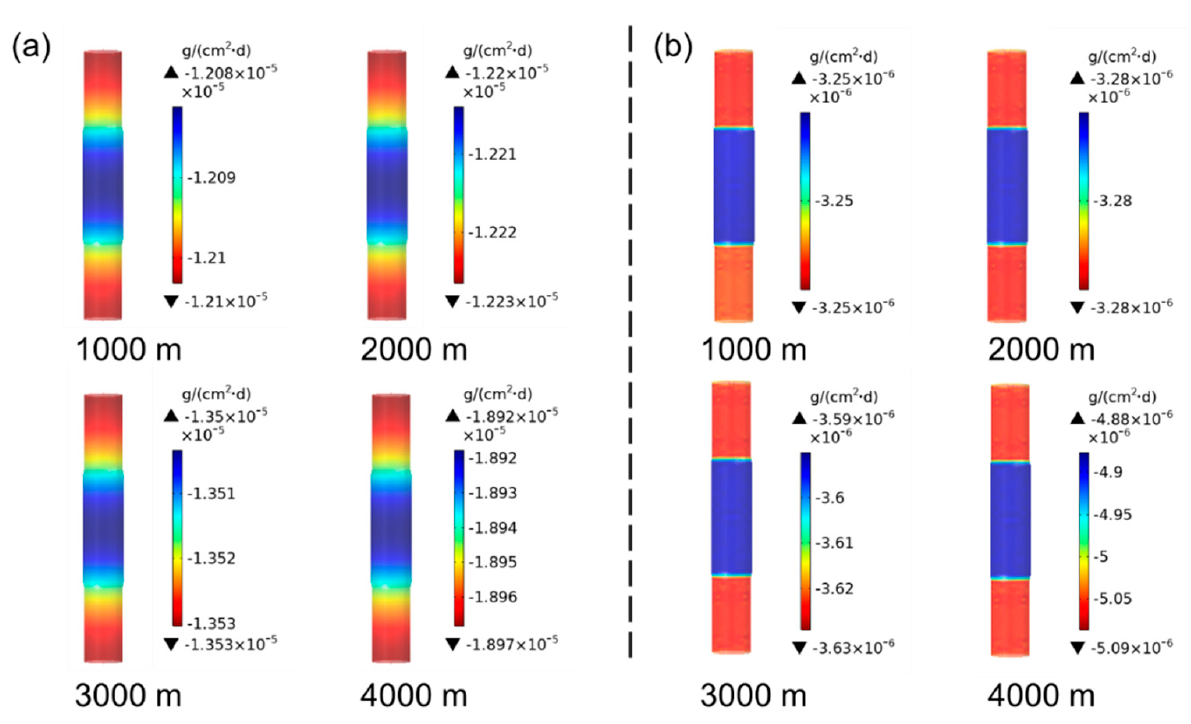
Figure 3. Corrosion rate distributions of the ( a ) 27CrMoV substrate and ( b ) WC–10Co4Cr coatings at different drilling depths for the drill pipe obtained by simulation.